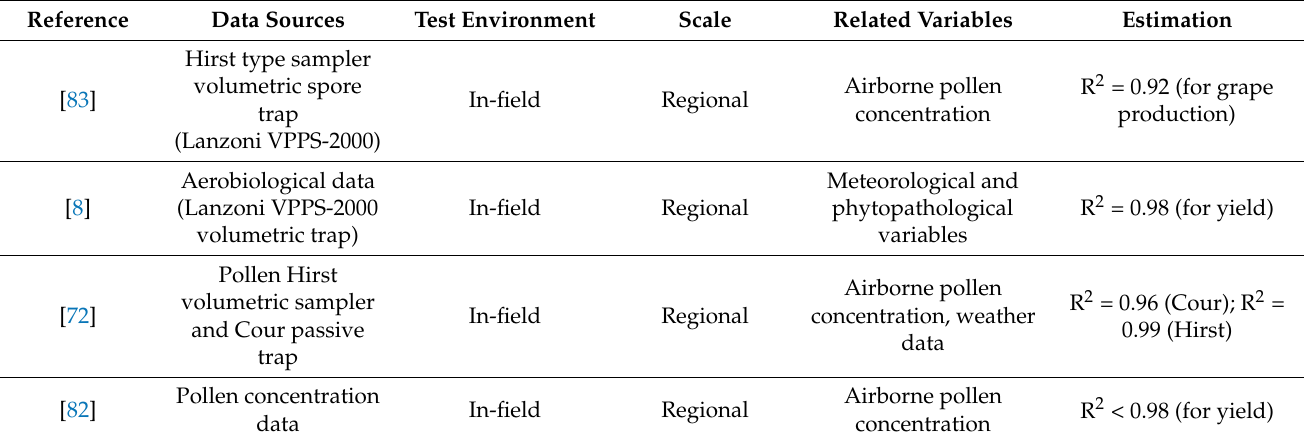
Table 4. Summary of records included in the systematic review (data-driven models based on